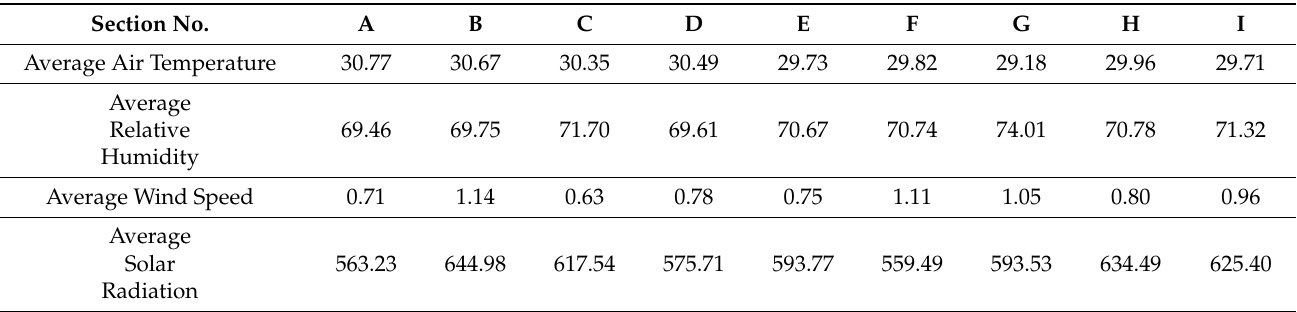
Table A2. The average air temperature ( ◦ C), the average relative humidity (%), the average wind speed (m/s), and the average solar radiation (W/m 2 ) of each section on 11 September and 12 September from 12:00 to 12:30.